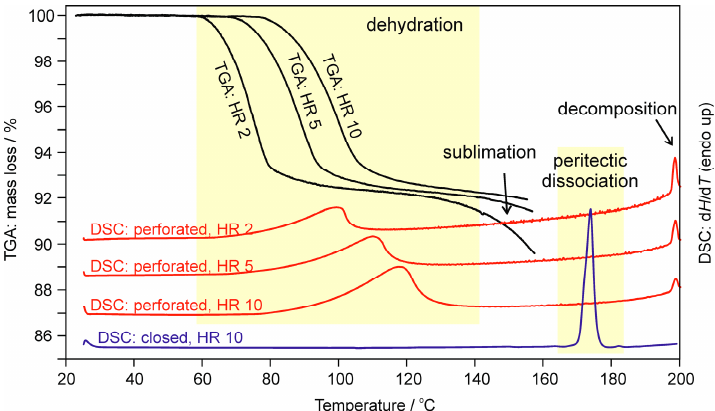
Figure 3. Differential Scanning Calorimetry (DSC) and Thermogravimetric Analysis (TGA) thermograms of 1-Hy1 . Numbers correspond to heating rates in °C min − 1 .